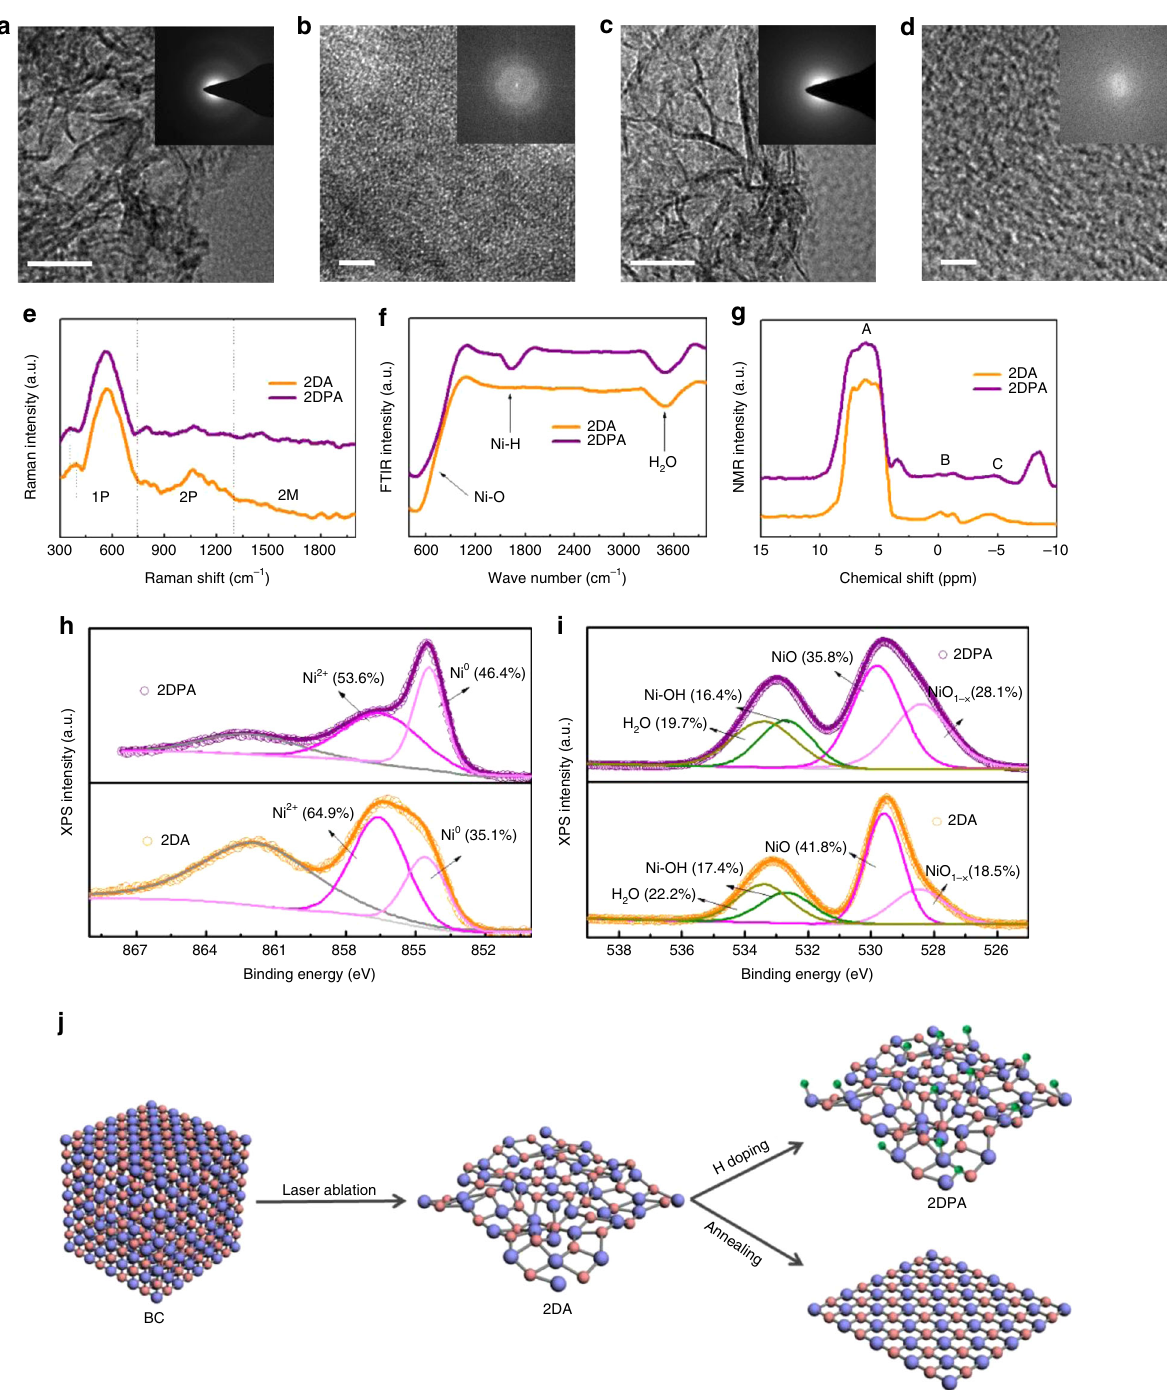
Fig. 1 Morphologies and structures of 2DA and 2DPA. a , b TEM images (insets: SAED patterns) of 2DA ( a ) and 2DPA ( b ). c , d HRTEM images (insets: FFT patterns) of 2DA ( c ) and 2DPA ( d ). Scale bars, 20, 2, 20 and 2 nm in a , b , c and d , respectively. e – i Raman, FTIR, 1 H NMR, Ni 2p 3/2 XPS spectra and O 1 s XPS spectra of 2DA (orange) and 2DPA (purple). j Schematic representation of the preparation processes of the four samples. Ni: blue balls, O: pink balls, H: cyan edge atoms 31 . The Ni – OH and NiO 1 − x contents in 2DC are adsorbed H 2 O. The deconvolution results are shown in Supplementary Table 2. It is known that the edge atoms are increased due to the 2D effect. Considering that the morphologies generally under-coordinated in the surface shell of a material. For of 2DA and 2DC are similar, the increase of the Ni 0 -like defects in 2DA should be due to the amorphization-induced atom NiO, the under-coordinated Ni atoms (Ni 0 -like defects) may exist rearrangement and coordination defects, which has been reported in two forms: NiO 1 − x and/or Ni-OH. Compared with BC, 2DC before 10,32,33 . In 2DPA, due to the electron-donating of the doped possesses an open-framework construction endowing abundant